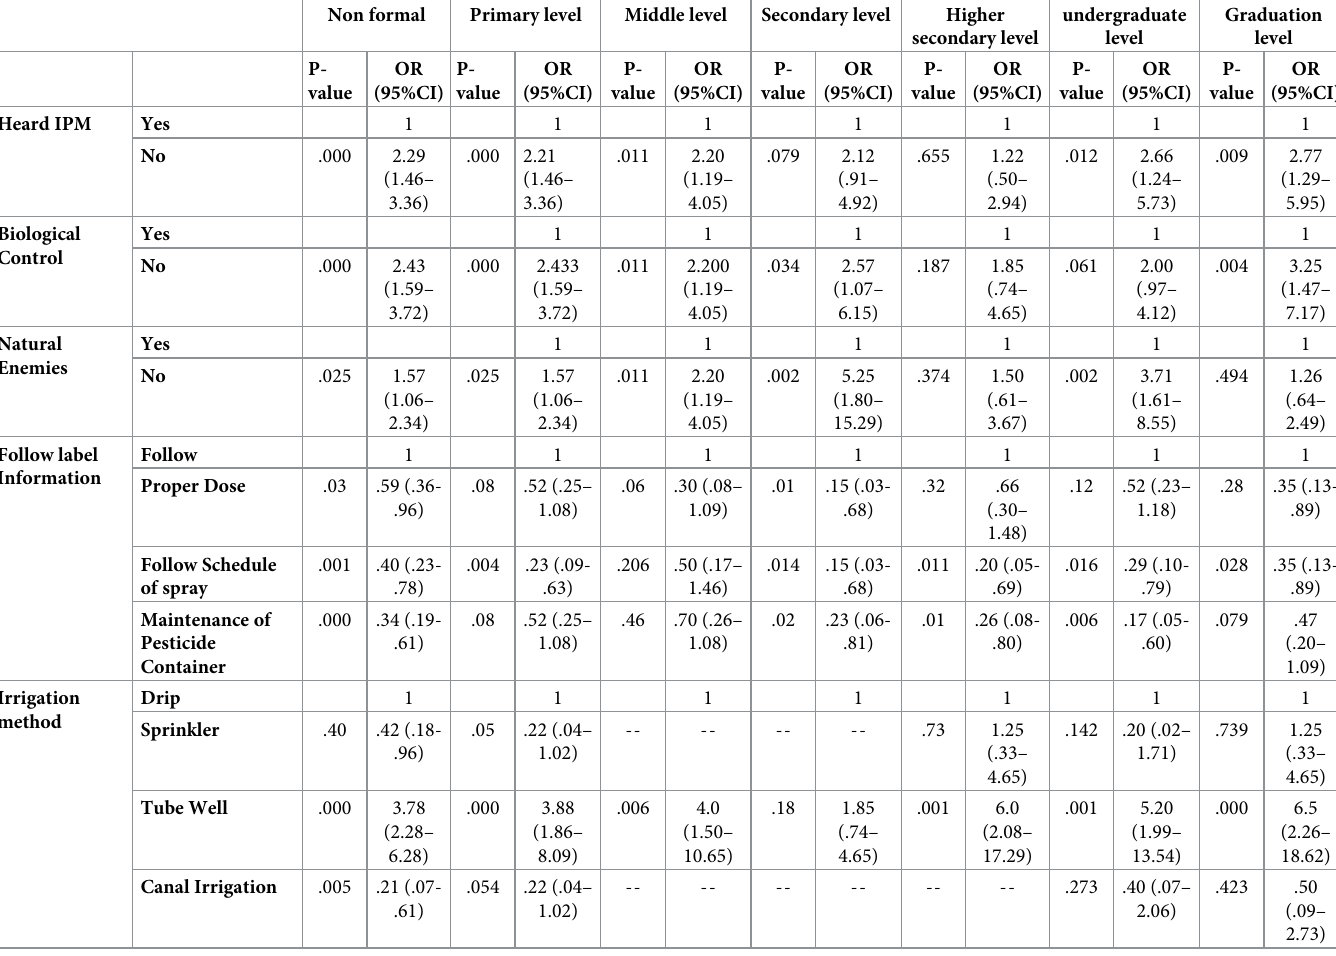
Table 4. Summary of univariate regression analysis column of the table refers to the education level of the farmers and rows refer the practices of farmers. Shown are the odd Ration (OR) and 95% confidence interval (95%